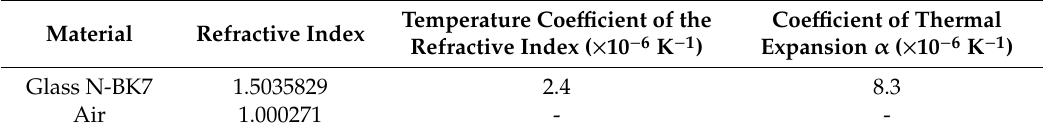
Table 1. Properties for the glass [23] and air